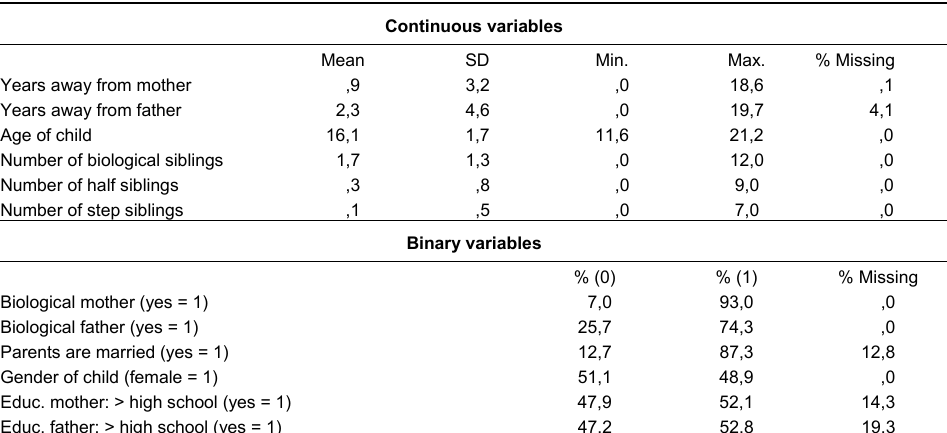
Descriptive statistics for the independent